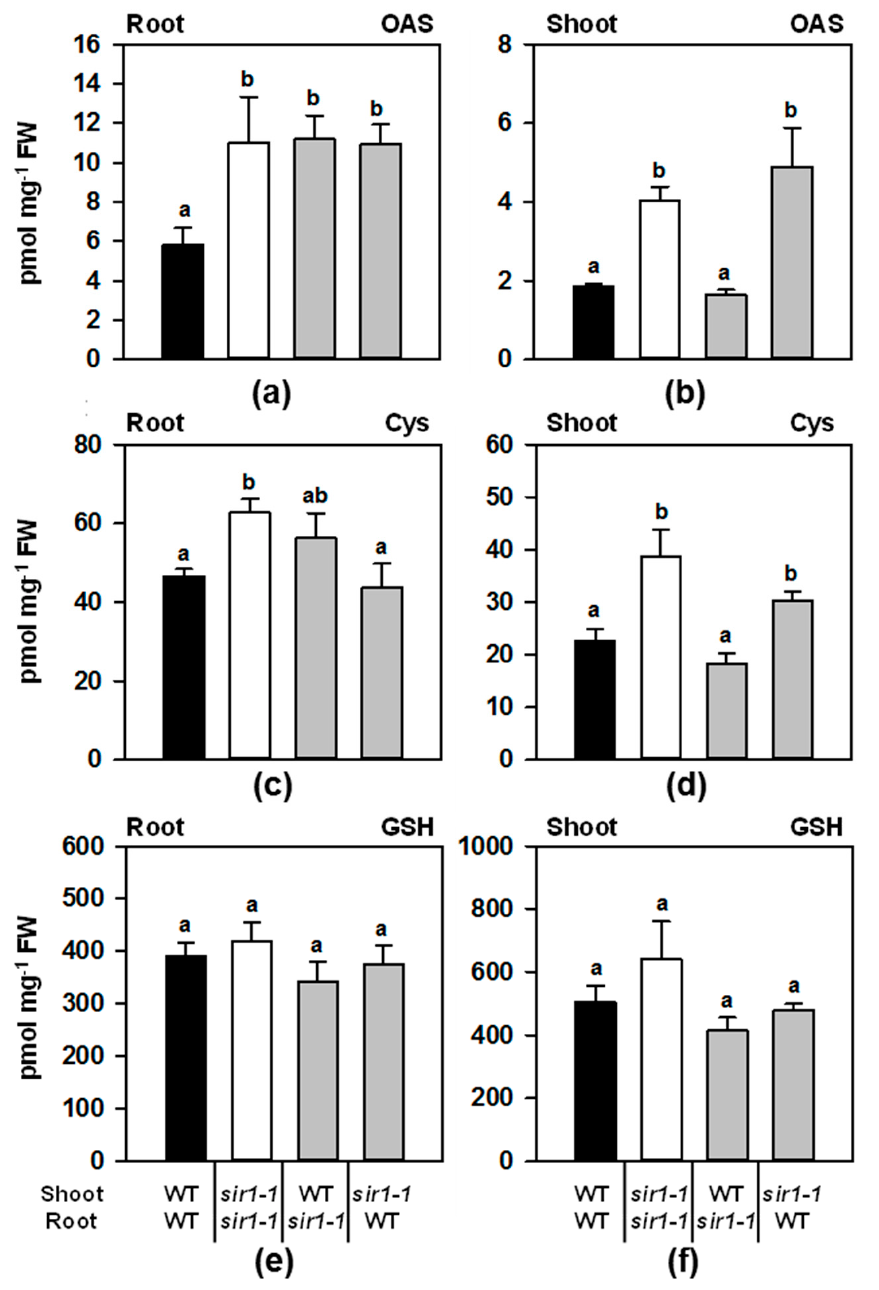
Figure 4. Steady-state levels of OAS and thiols in micrografted plants. Concentrations of OAS ( a , b ), Cys ( c , d ) and GSH ( e , f ) in roots ( a , c , e ) and shoots ( b , d , f ). Data represent the means ± SE ( n = 4). Different letters indicate individual groups identified by multiple pairwise comparisons with a Holm–Sidak, one-way ANOVA ( p , 0.05) followed by the Student–Newman–Keuls posthoc